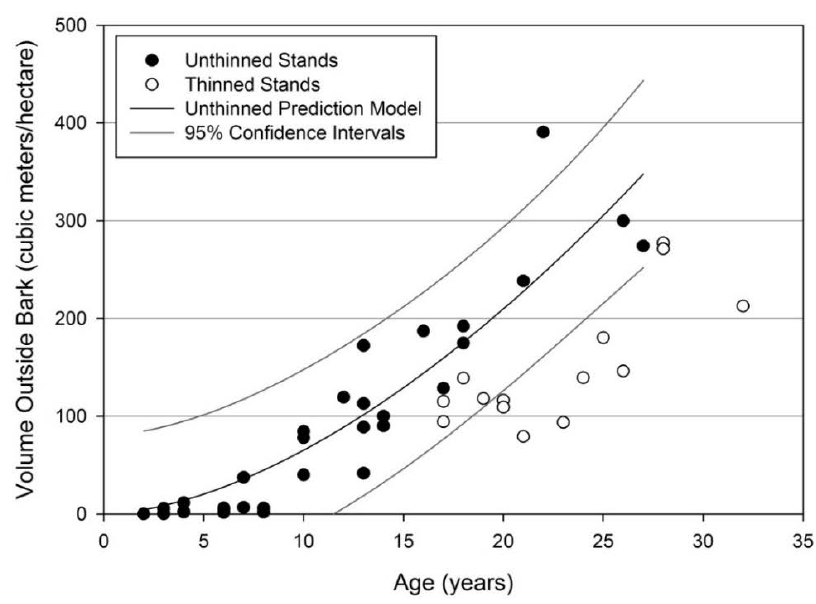
Figure 9. Stem volume outside bark for loblolly pine stands on reclaimed mineland in east Texas. Stem volume at the stand level is at least temporarily reduced due to thinning; however, yields following thinning cannot be modeled.